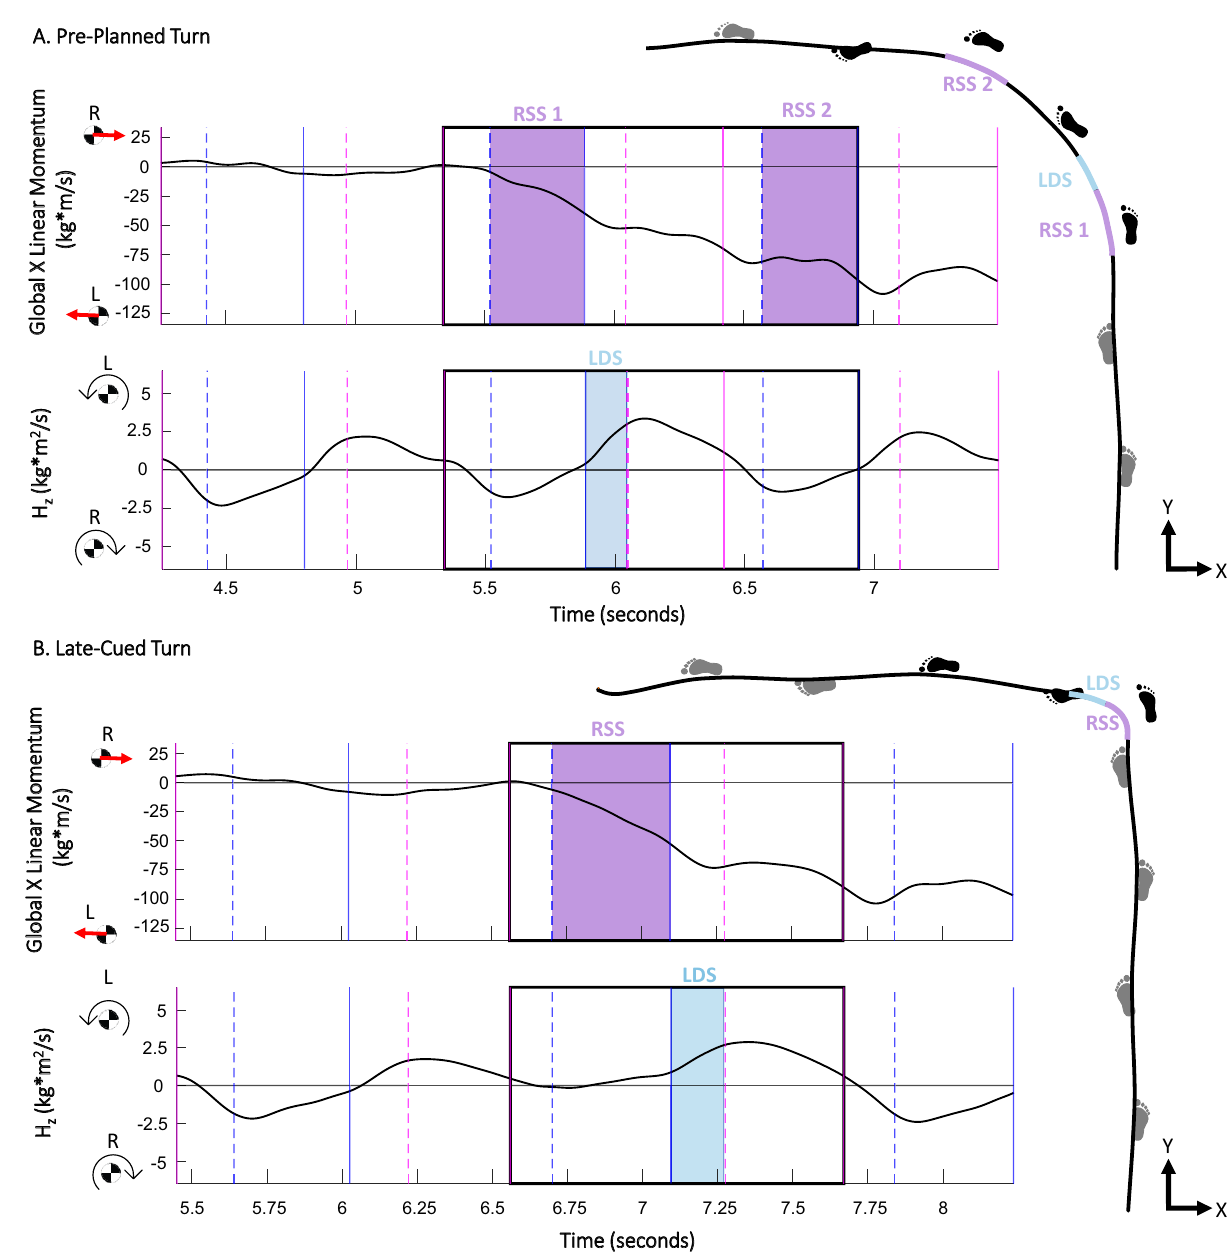
Figure 2. Example timeseries of the global X-axis linear momentum and transverse-plane angular momentum (H z ) during ( a ) a pre-planned turn and ( b ) a late-cued turn. Vertical solid lines indicate heel-strike events and vertical dashed lines indicate toe-off events for the right foot (pink) and left foot (blue). The black-outline boxed region indicates the turn phase and color-filled boxes highlight right single support (RSS; purple) and left double support (LDS; blue) gait phases. These two trials provide examples of when the largest change in global leftward X-axis linear momentum occurred during RSS and the largest change in H z occurred during LDS. Transverse-plane plots are included to provide context of the COM path and footfall